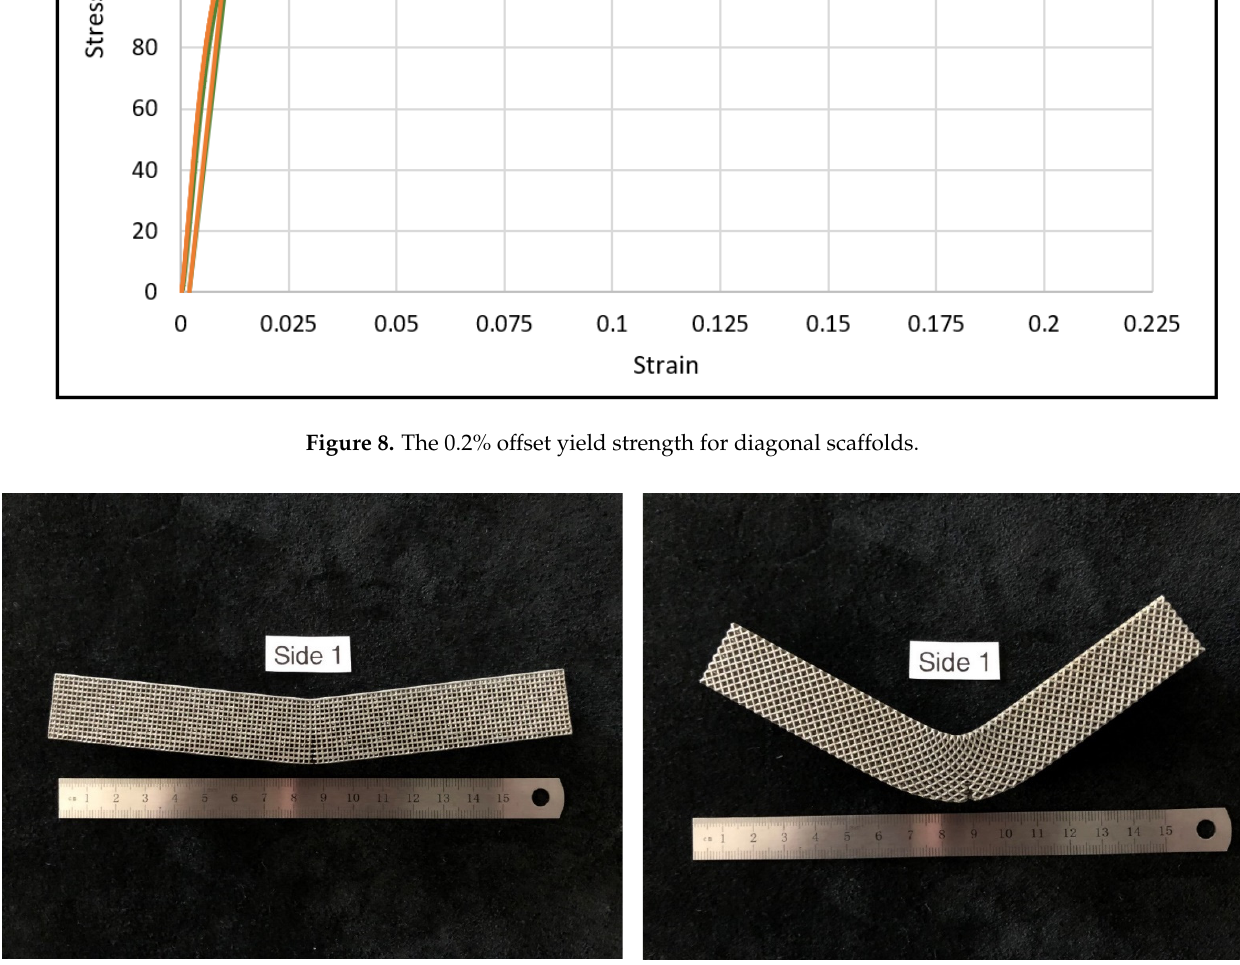
Figure 9. Deformed specimens ( a ) cubic scaffold, ( b ) diagonal scaffold. As for validating shear modulus results, the shear strain has been calculated using The stress-strain curve for the diagonal scaffold resembles the behavior of a cortical Equation (10) at various load values, and the shear stress has been calculated using Equa- bone loaded longitudinally. In contrast, the stress-strain curve for the cubic scaffolds is tion (12) from the measured strain gauge readings. The shear stresses with the